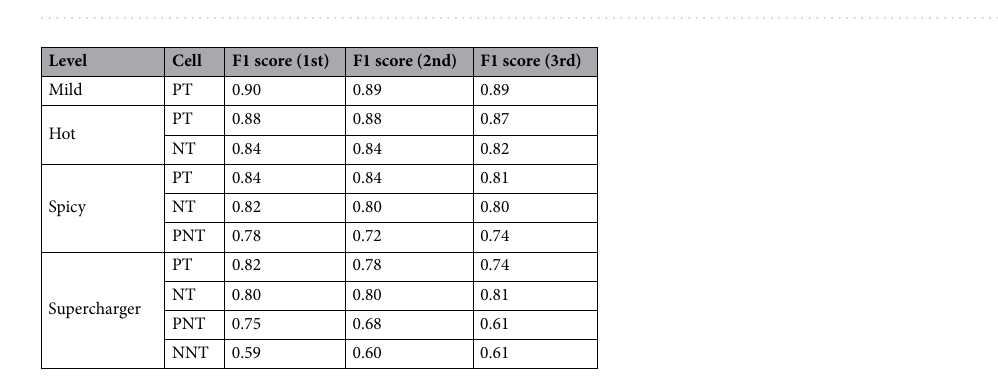
Figure 4. Examples of cell annotation results by the pathologist and three participants who achieved the top three accuracies in the Supercharger level. (Positive Tumour: red; Negative Tumour: green; Positive Non- Tumour: yellow; Negative Non-Tumour: blue). The annotations by the pathologists were used as ground truth.